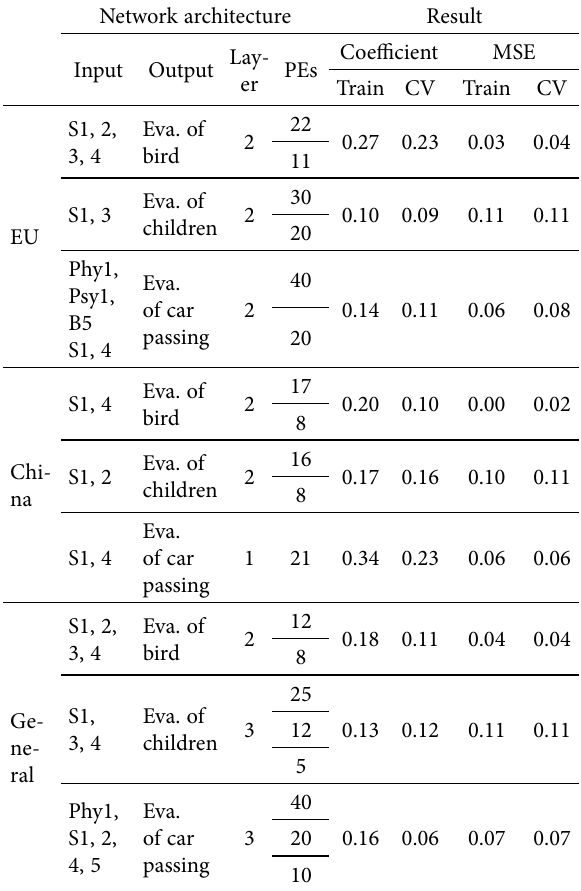
Table 3. Group and general models for predicting sound preference evaluations Network architecture